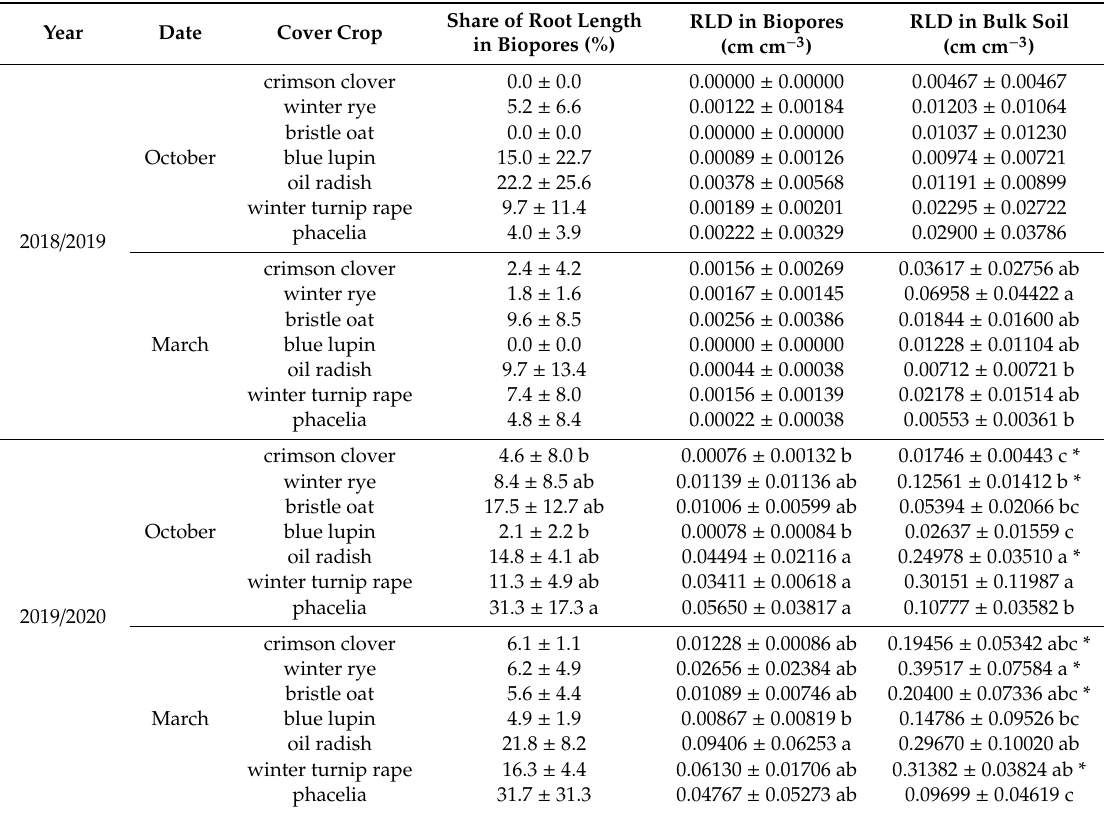
Table 6. Mean values ± standard deviation ( n = 3) of share of root length in large-sized biopores and root length density (RLD) in large-sized biopores and in bulk soil in the subsoil (30–90 cm) for di ff erent cover crops before (October) and after winter (March) in two seasons (2018 / 2019 and 2019 / 2020). Di ff erent letters indicate significant di ff erences ( α = 0.05) for share of root length in large-sized biopores, RLD in biopores or RLD in bulk soil within one date. * indicates significant di ff erence between RLD in biopores and in bulk soil (t-test, α = 0.05) for one crop within on